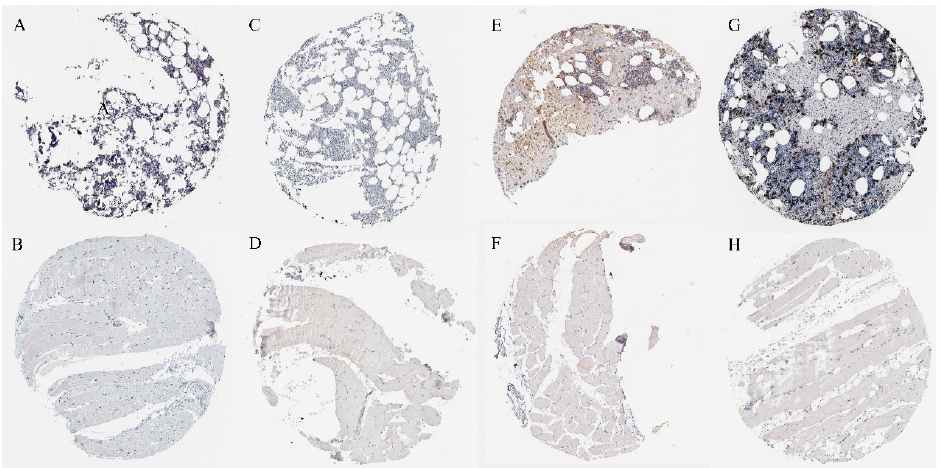
Figure 5. ( A ) Expression of JUN protein in the bone marrow (one of the outcomes). ( B ) Expression of JUN protein in skeletal muscle. ( C ) Expression of IL6 protein in the bone marrow. ( D ) Expression of IL6 protein in skeletal muscle. ( E ) Expression of ATF3 protein in the bone marrow. ( F ) Expression of ATF3 protein in skeletal muscle. ( G ) Expression of HMOX1 protein in the bone marrow. ( H ) Expression of HMOX1 protein in skeletal muscle.